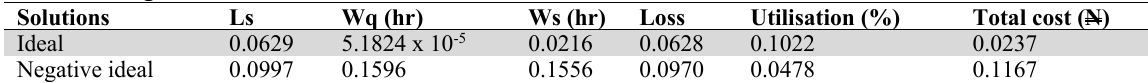
Ideal and negative ideal solutions Solutions